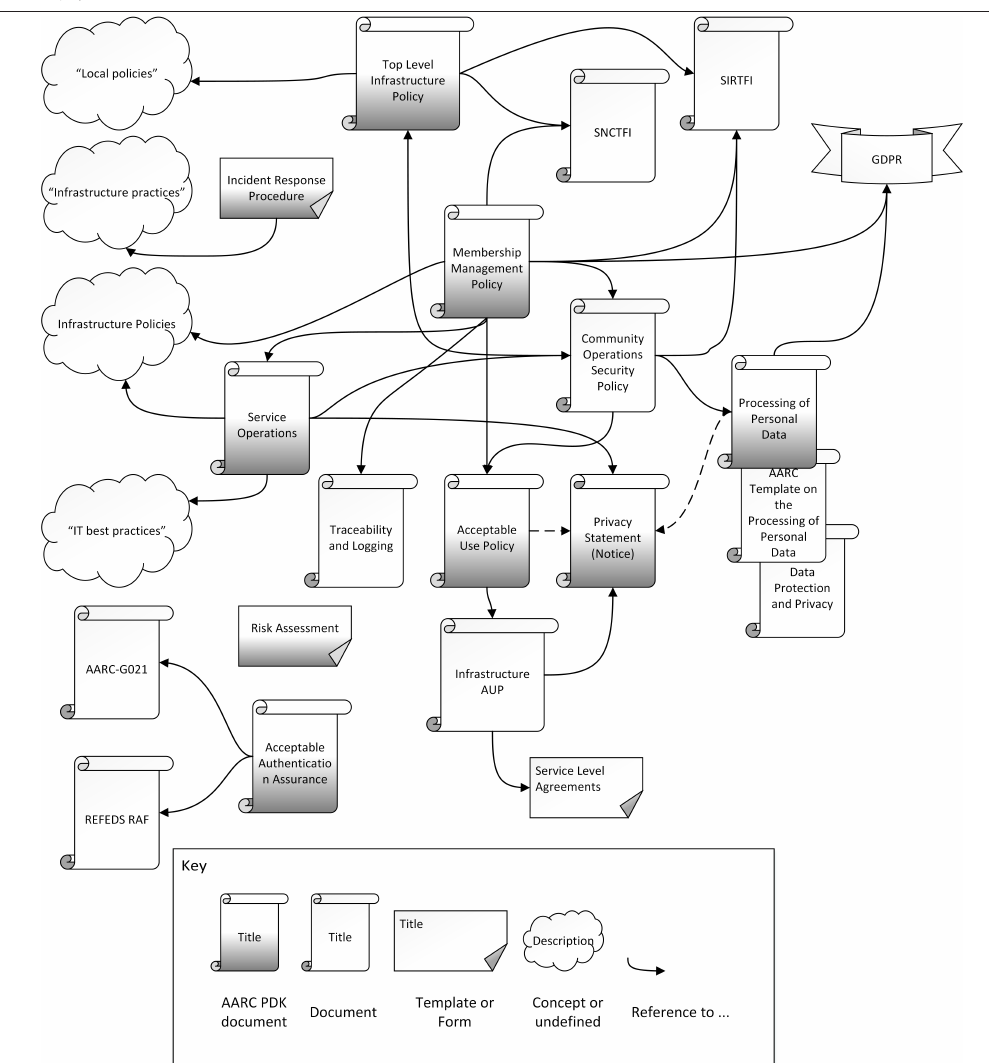
Figure 1. Relationships between the AARC Policy Development Kit and other documents